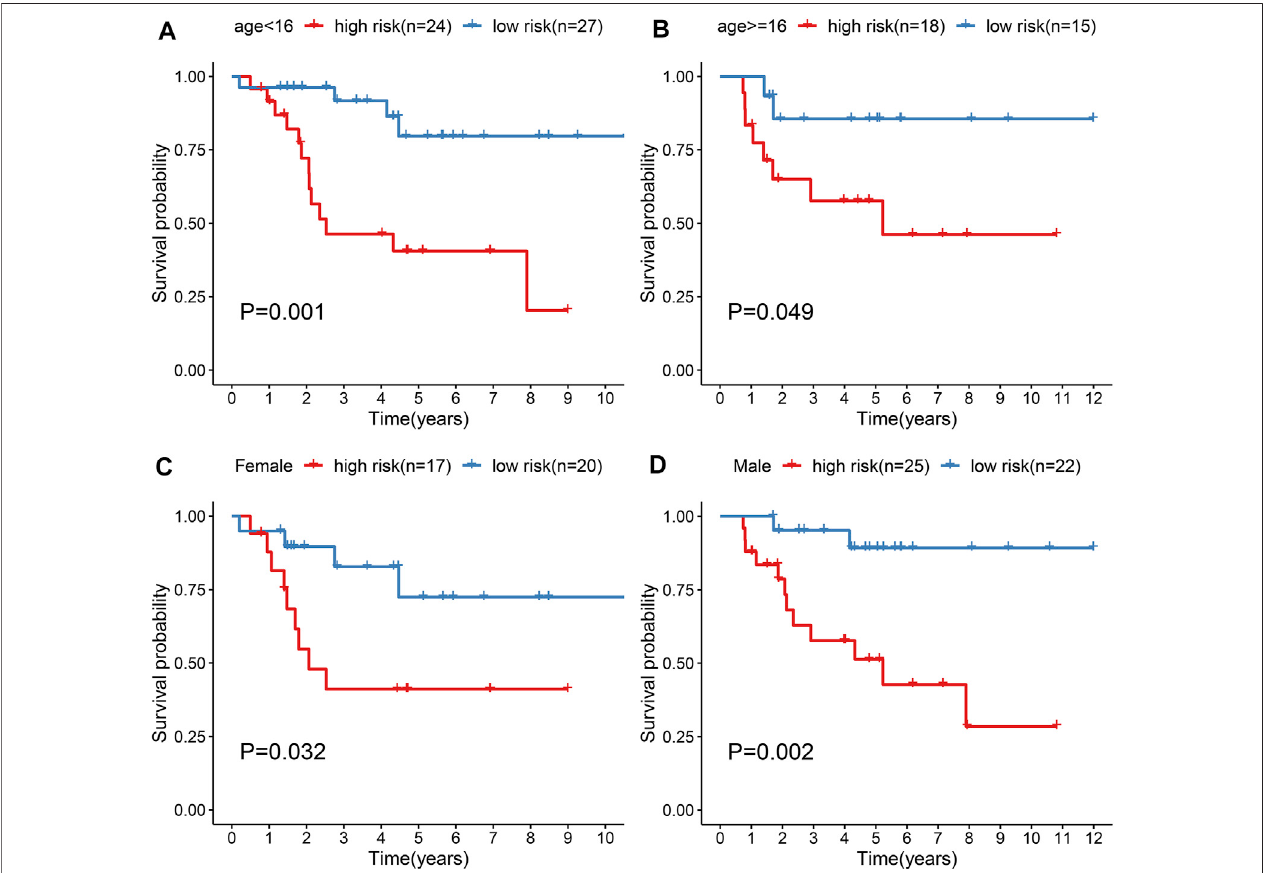
FIGURE 5 | Evaluation of prognostic value of the gene signature in osteosarcoma by subgroup analysis. (A, B ) Kapan-Meir curves of OS between high- and low- riskpatients in (A) age < 16and (B) age ≥ 16subgroups. (C,D) Kapan-Meircurves ofOSbetweenhigh-and low-riskpatients in (C) femaleand (D) malesubgroups.The survival differences were assessed by log-rank